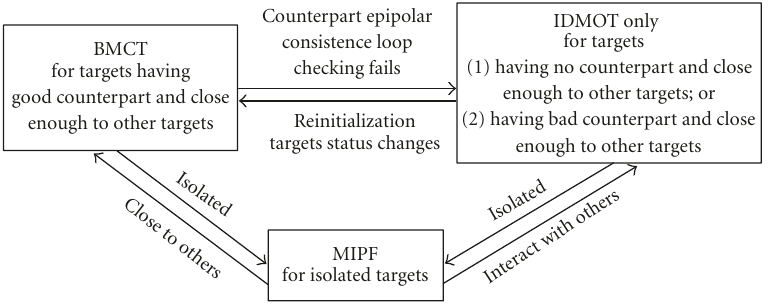
Figure 6: Triangle transition algorithm; BMCT: the proposed distributed Bayesian multiple collaborative cameras multiple-target tracking approach; IDMOT: interactively distributed multiple-object tracking [14]; MIPF: multiple independent regular particle filters [38].